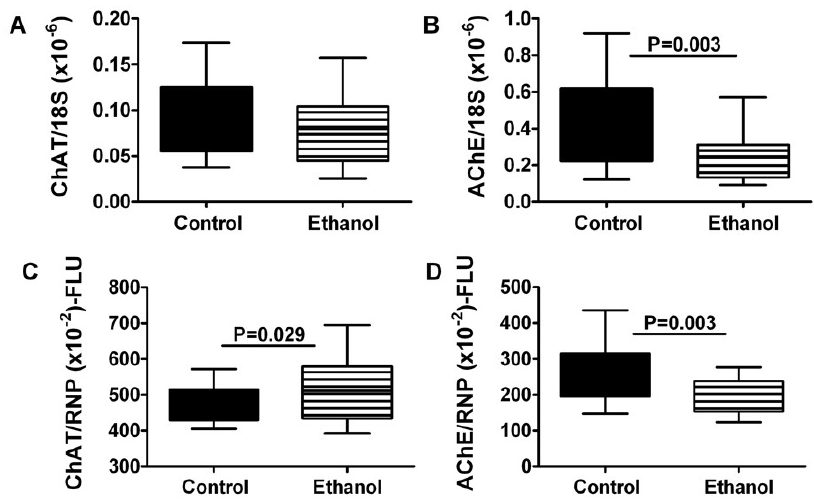
Figure 4. Chronic ethanol feeding impairs expression of acetylcholinesterase in skeletal muscle. Gastrocnemius muscles from control and chronic ethanol fed rats were used to measure ( A , B ) mRNA expression or ( C , D ) immunoreactivity to ( A , C ) choline acetyltransferase (ChAT) and ( B , D ) acetylcholinesterase. mRNA was measured by qRT-PCR analysis with results normalized to 18S rRNA, and immunoreactivity was measured using a direct binding duplex ELISA in which large ribonuclear protein expression was used to normalize the levels of ChAT and AChE proteins. Inter-group comparisons were made with Student t -tests.